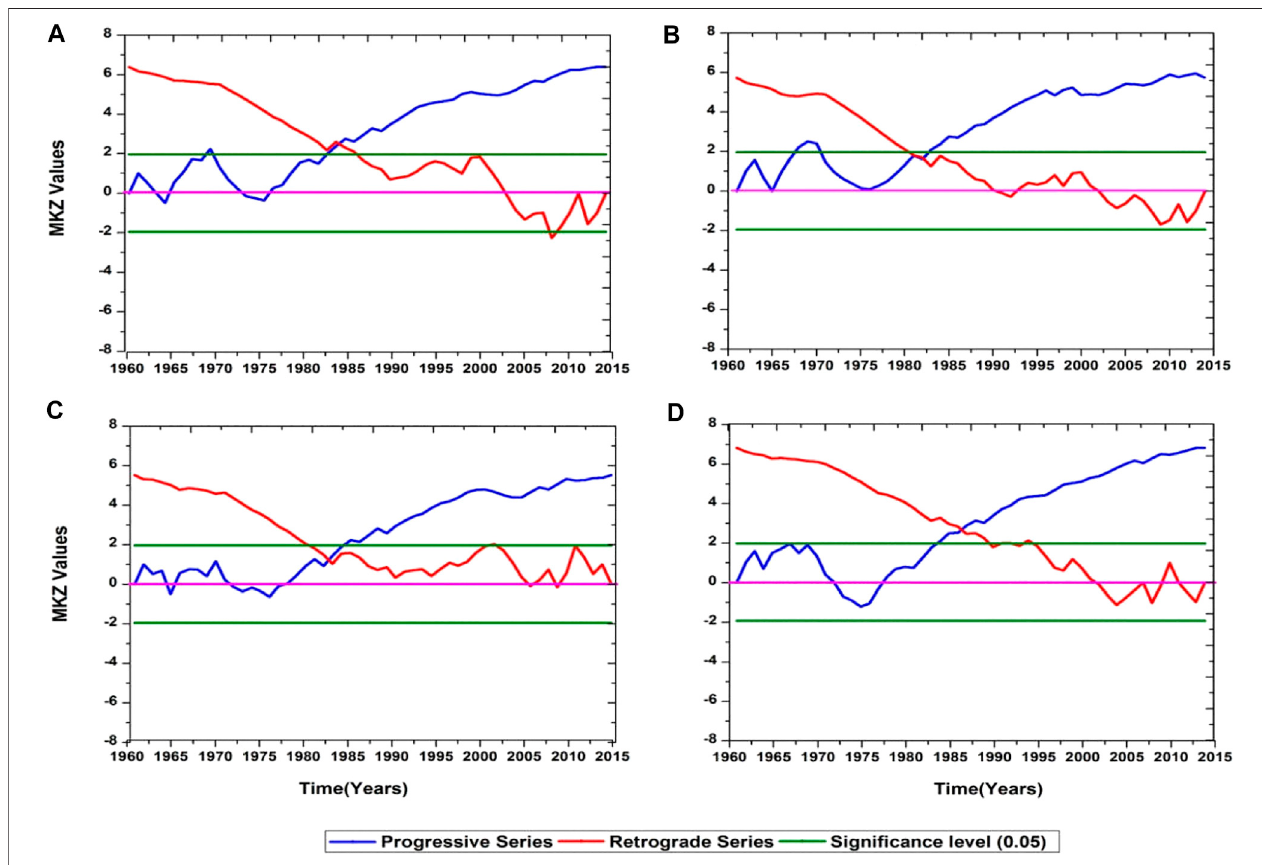
FIGURE 7b | Same analysis for